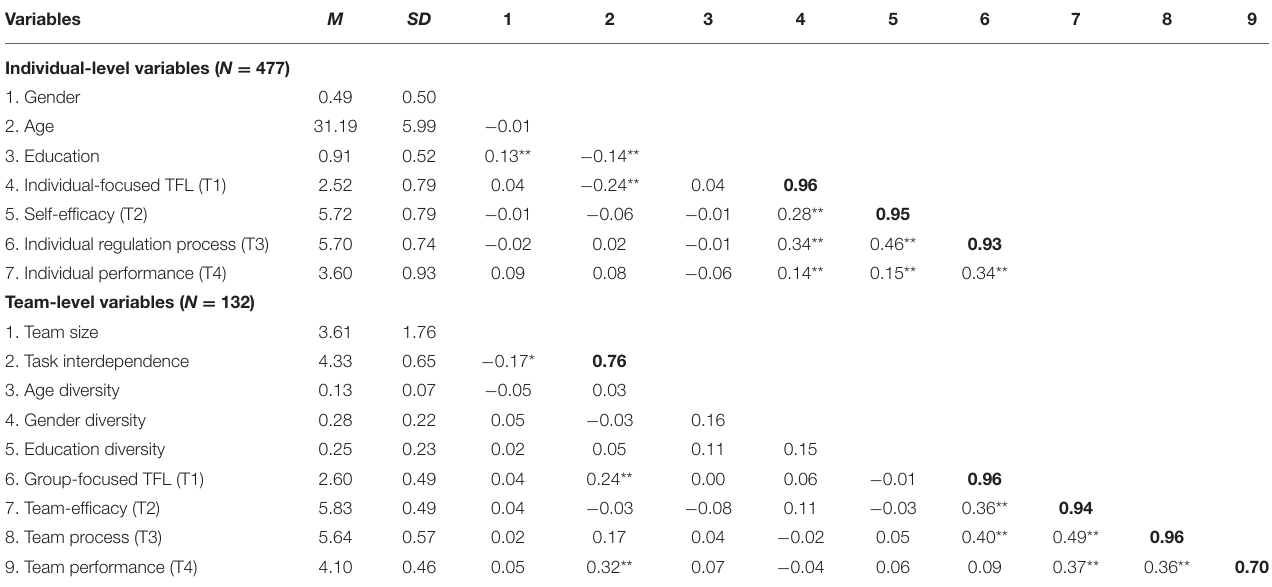
TABLE 1 | Descriptive statistics and